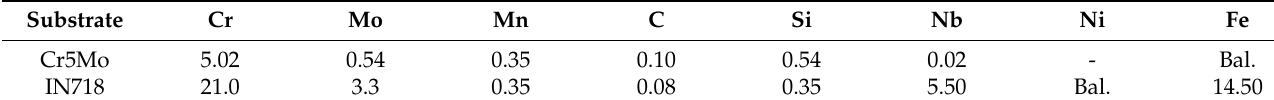
Table 1. Chemical composition of Cr5Mo substrate and IN718 powder.